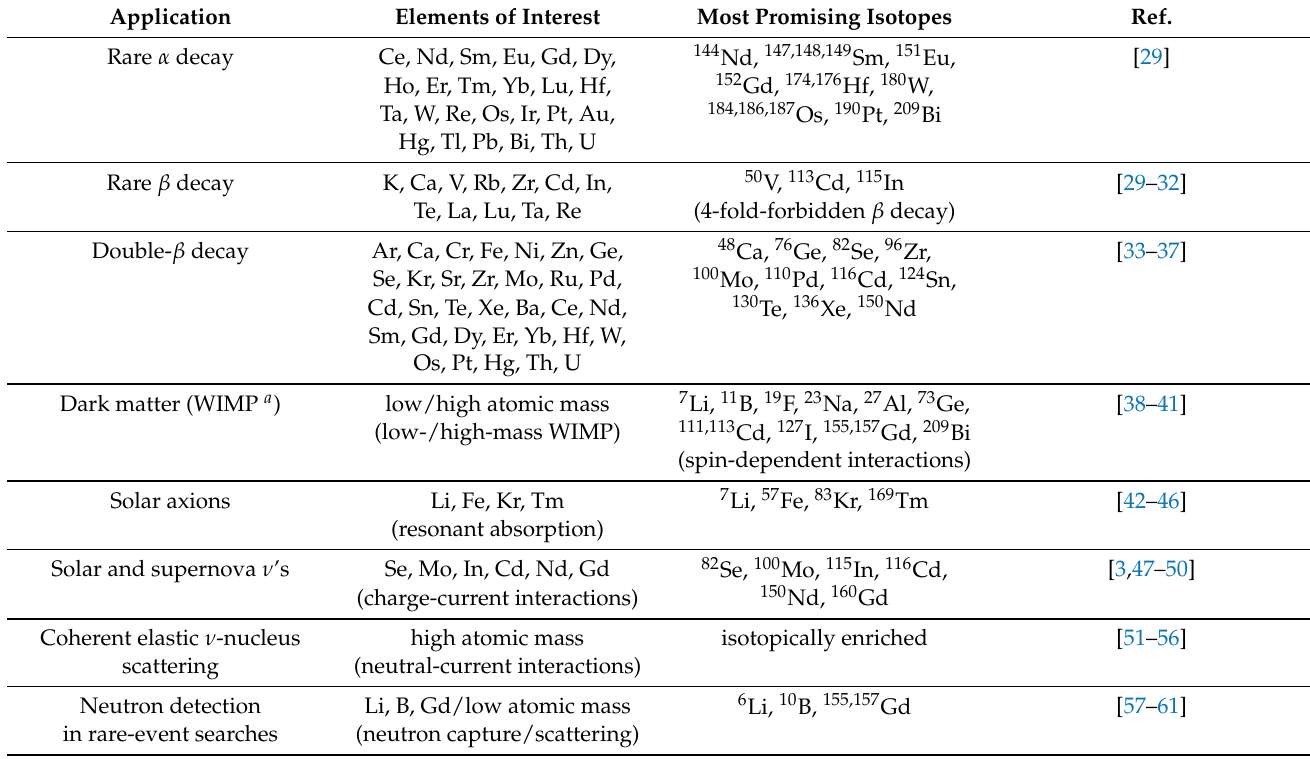
Table 1. Possible applications of particle detectors containing elements (isotopes) of interest for rare-event searches.